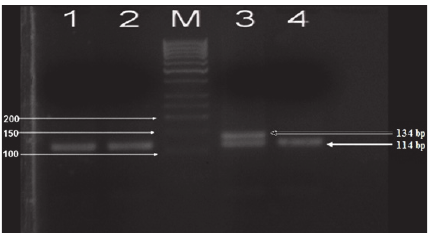
Figure 1: PCR-RFLP agarose gel electrophoresis of RANTES -28C > G polymorphism (1, 2, and 4 homozygote normal (CC) , 3 heterozygote polymorphic (CG) , M: 50bp DNA